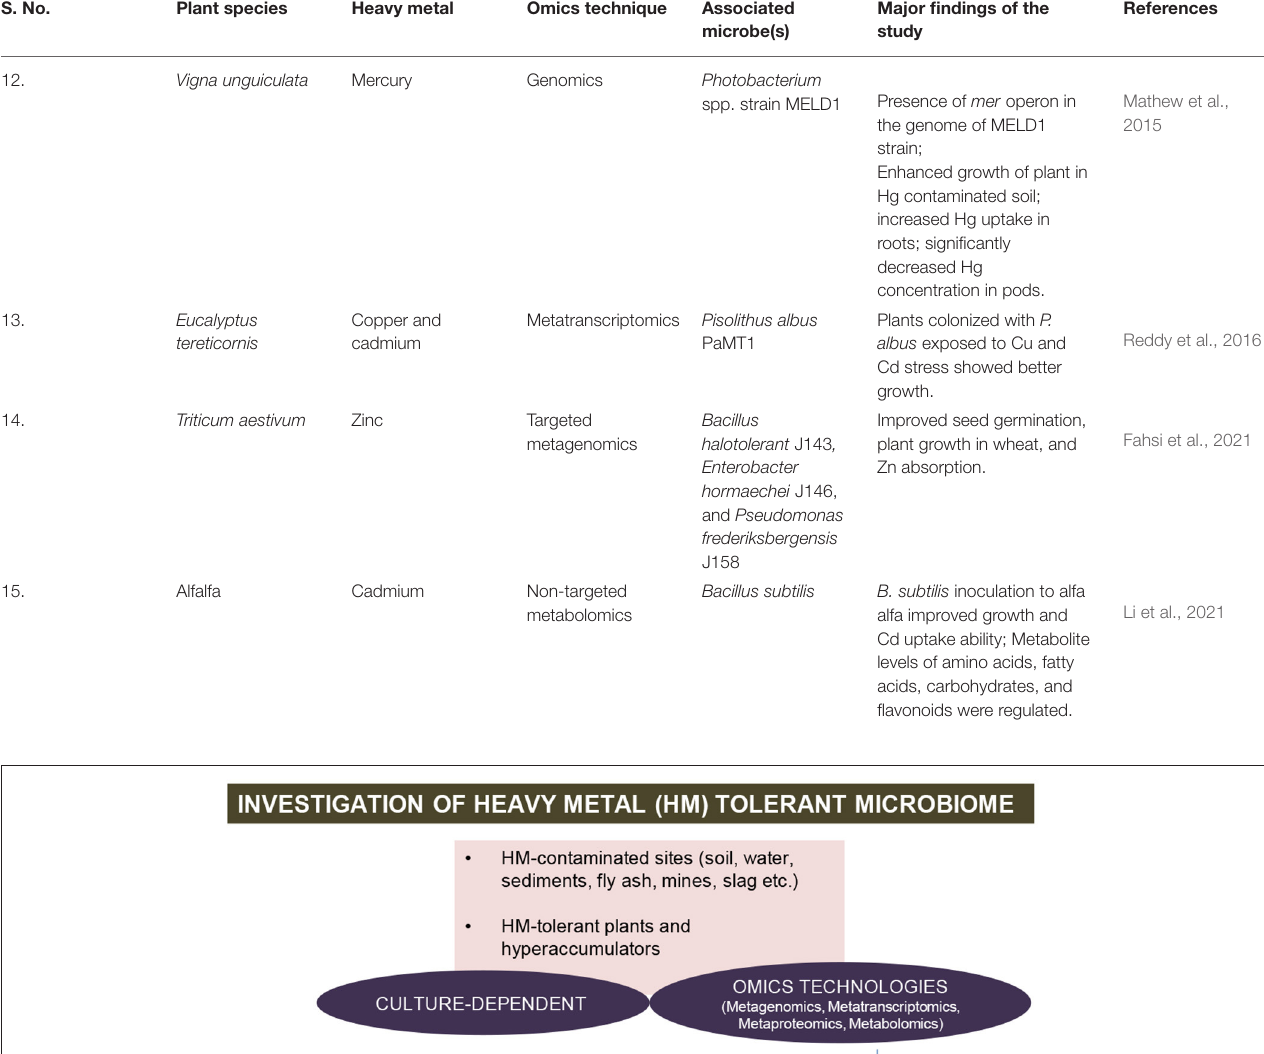
(Meena et al., 2017; Mishra et al., 2021b). The targeted amplicon sequencing involves specific amplification of ribosomal RNA genes (16S rRNA for bacteria and archaea and 18S rRNA or ITS for fungi) for determining the composition and diversity of microbial communities present in the samples. Being a